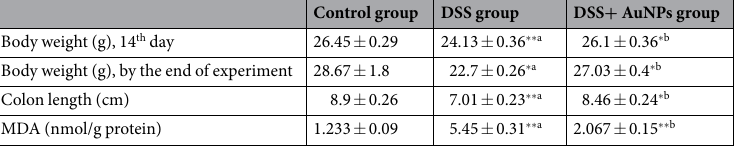
Table 1. Body weights, colon length and tissue malondialdehyde (MDA) level in different groups. Values are expressed as mean ± standard error of means (SEM) of n = 8 animals. a P compared with control group.